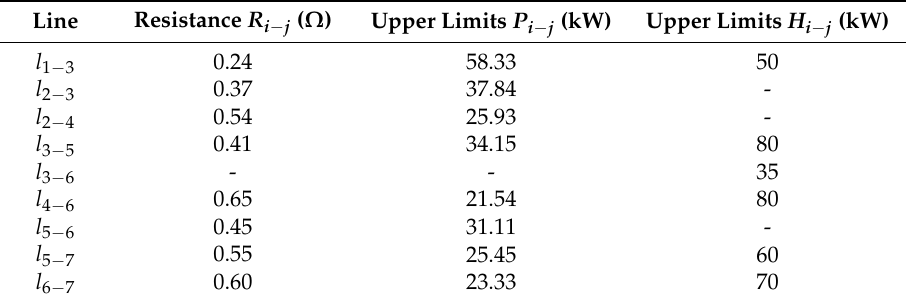
Table 4. Resistances and upper limits of power transfer of connection